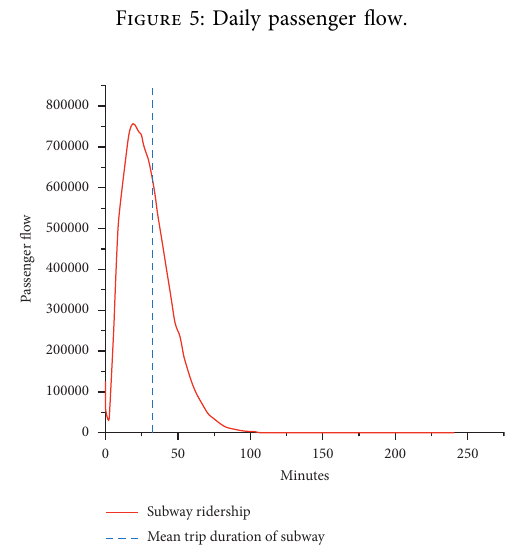
Figure 6: Distribution of subway travel time.